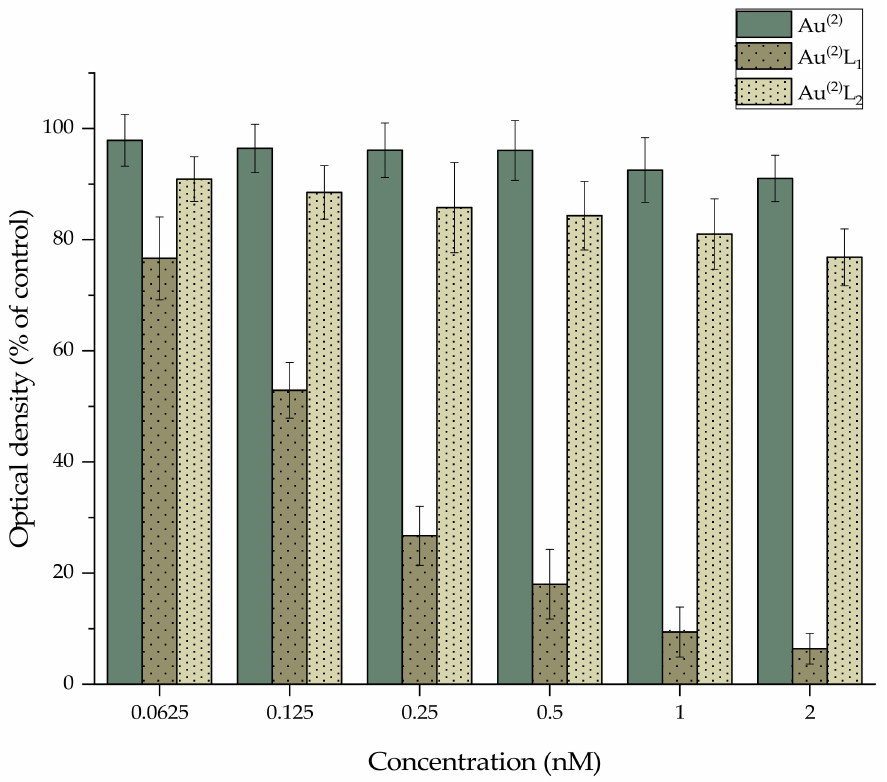
Figure 5. MTT assay of 4T1 cells treated with different concentrations of Au (2) , Au (2) L1, and Au (2) L2.